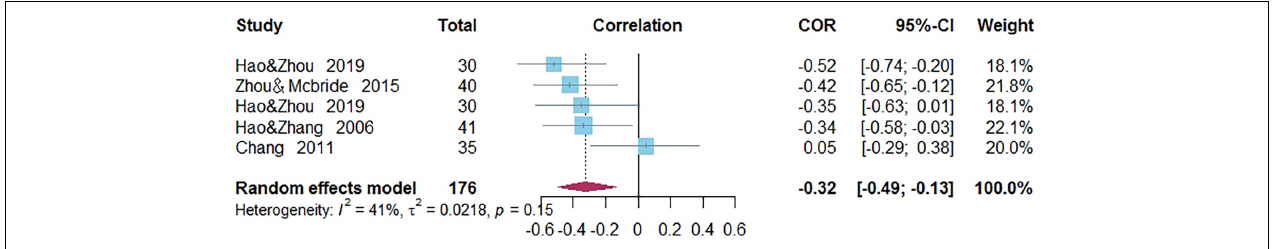
FIGURE 8 | Forest plot of the correlations between rapid automatized naming and Chinese word reading.